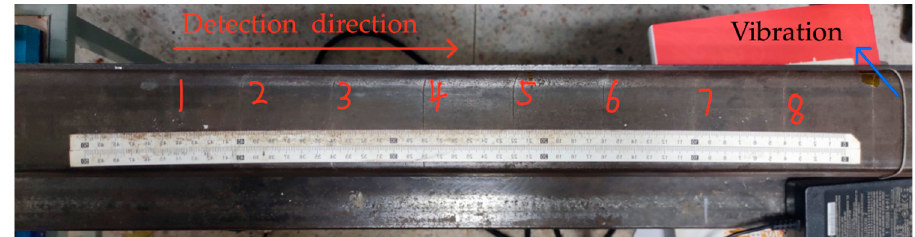
Figure 15. A rail with multiple artificial defects. Table 2. The width and depth of each defect.